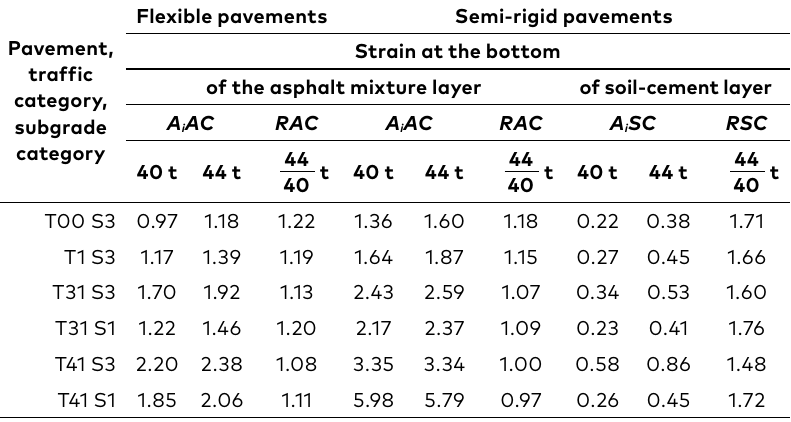
Table 6. Aggressiveness coefficients ratio